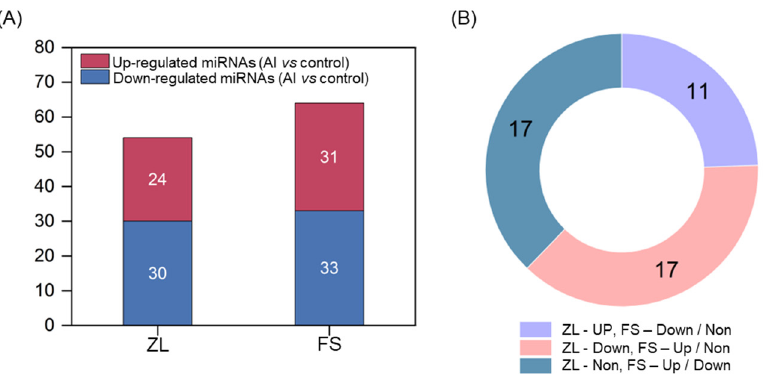
Figure 4. Al stress-responsive miRNAs in two olive genotypes. ( A ) Number of up- and down- regulated miRNAs of ZL and FS in response to Al stress. ( B ) Comparative analysis of Al stress- responsive miRNAs in two olive genotypes. Fold change (Al vs. control) is log 2 N, log 2 N ≥ 1 are up-regulated (Up), between − 1 < log 2 N < 1 are unchanged (Non) and log 2 N ≤ − 1 are down-regulated (Down), Adjusted p -value ≤ 0.01.